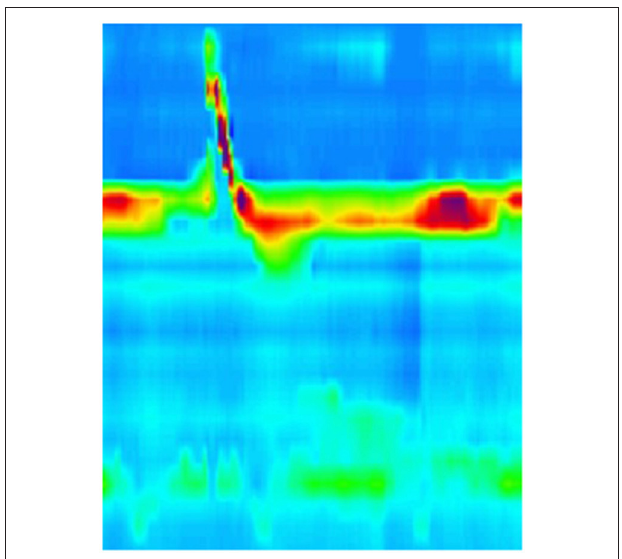
FIGURE 3 | High resolution manometry in eosinophilic esophagitis showing weak peristalsis with wet swallow in an adult. Reprinted with permission from Prof. Taher